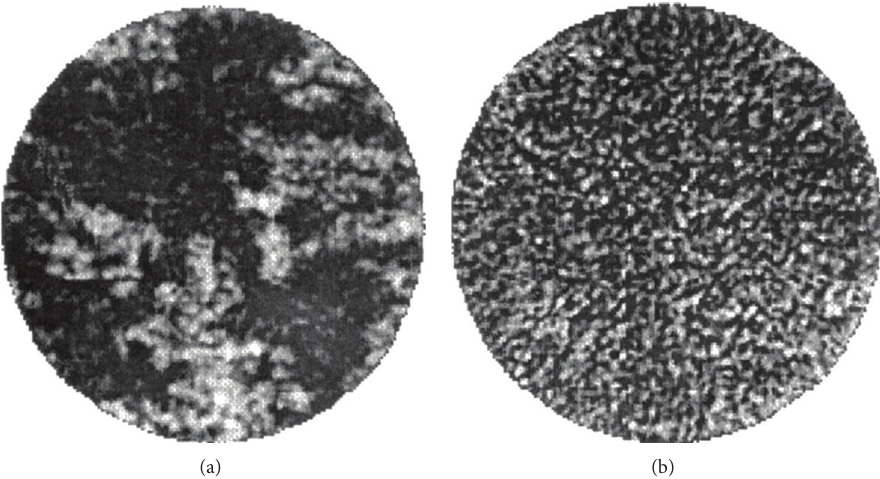
Figure 1: CT images of moisture distribution in the unsaturated Estaillades limestone at saturation of 92%: (a) prepared by drying; (b) prepared by wetting (after Cadoret et al. (1998)